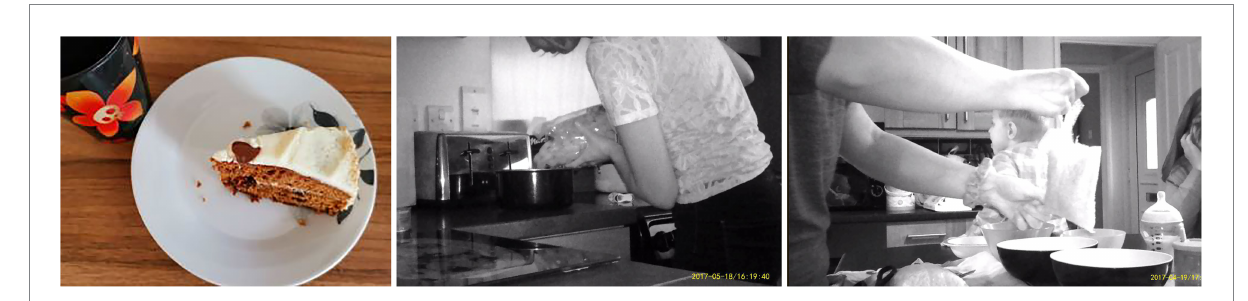
FIGURE 11 Determining the portion size by